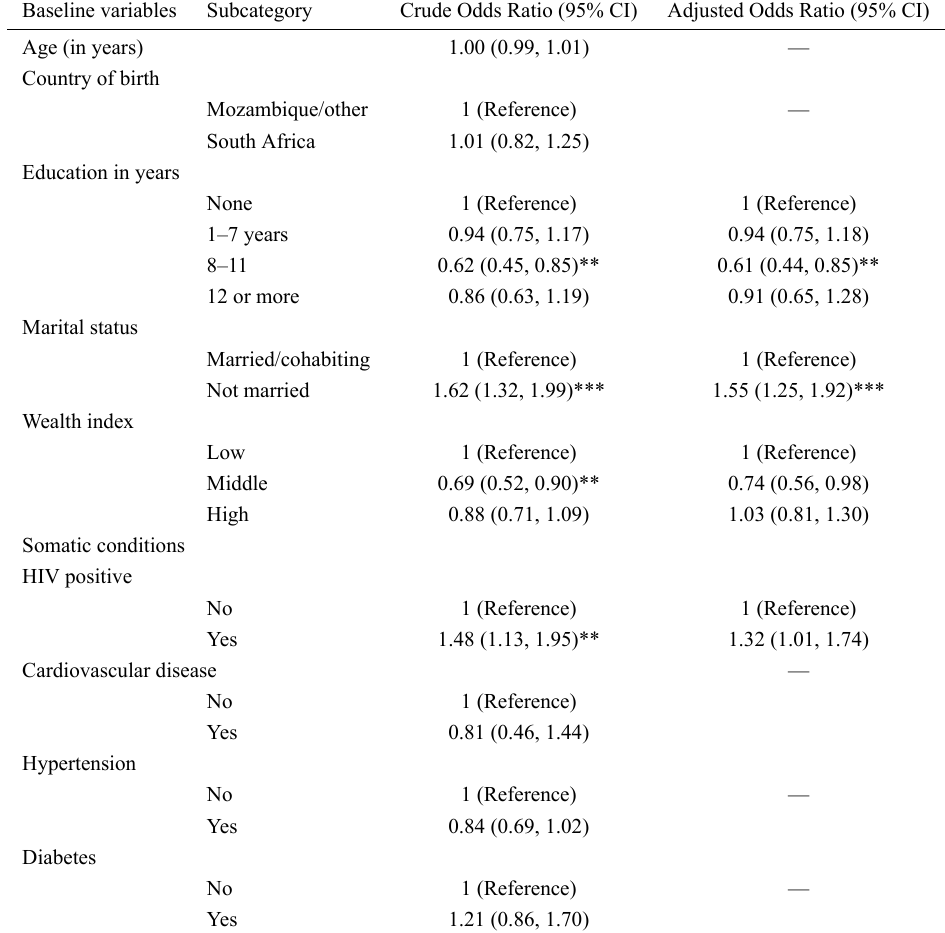
Table 2. Odds ratios for the association between somatic conditions, lifestyle factors, and incident depressive symptoms among men 40 years and older, HAALSI